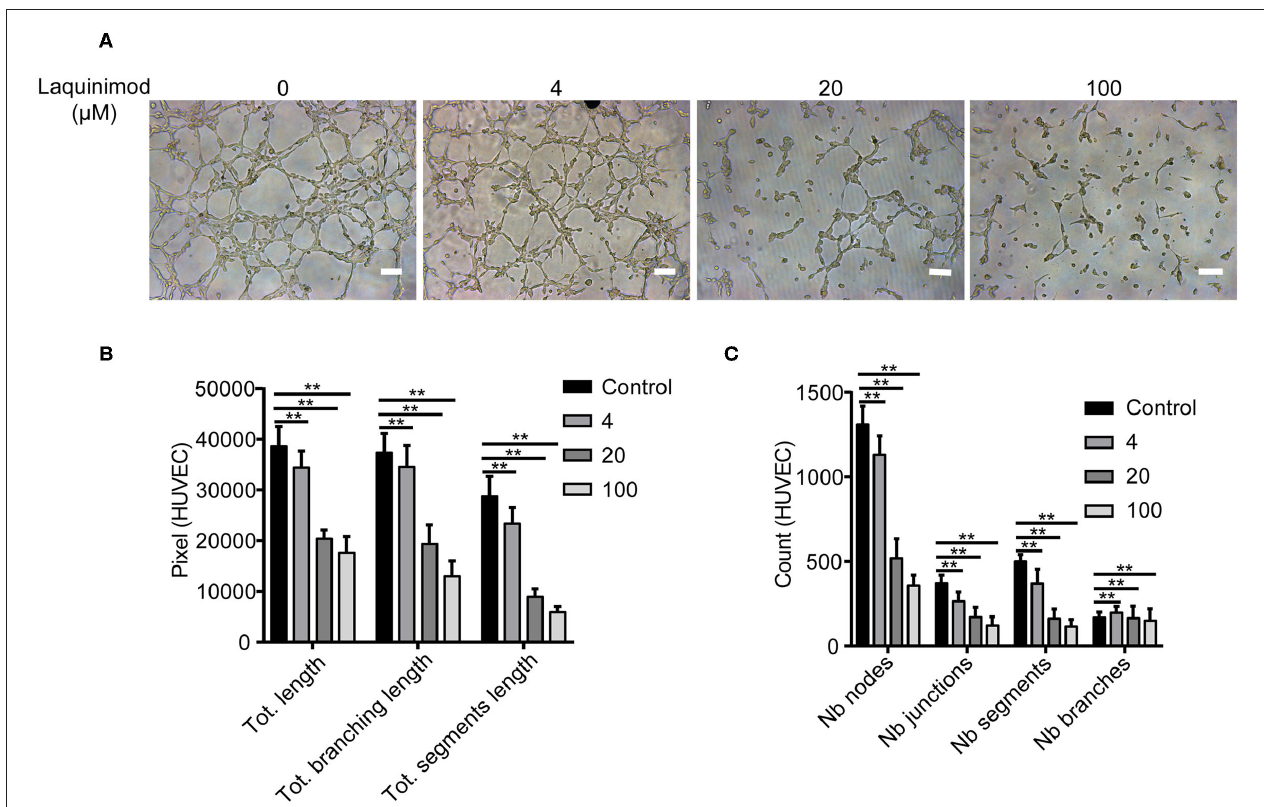
FIGURE 6 | The effect of laquinimod on tube formation in HUVECs. (A) HUVECs (10,000 cells/well) were seeded on Matrigel containing laquinimod in depleted medium. The cells were cultured for 12h at 37 ◦ C and 5% CO 2 . Photos were taken with an inverted microscope using a 10 × objective (four images per group). Scale bars = 100 µ m. (B,C) Tube formation was quantified by using Angiogenesis Analyzer for ImageJ. These data were analyzed, and all values were normalized to the analyzed area. The Nb of nodes, Nb of junctions, Nb of segments, Nb of branches, Tot length, Tot branching length, and Tot segment length were determined. PBS as control, ** p < 0.01, laquinimod vs. PBS-treated